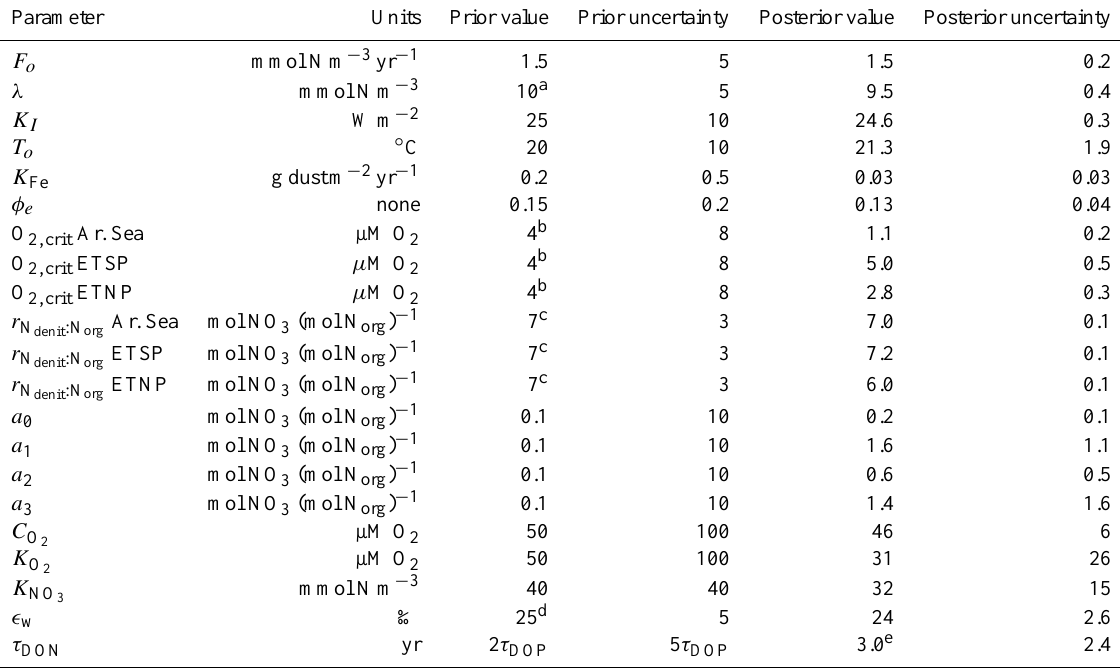
Table B1. Prior (pre-optimization) and posterior (post-optimization) values of the control parameters, and associated uncertainties. Prior uncertainties are 1 standard deviation of a normal